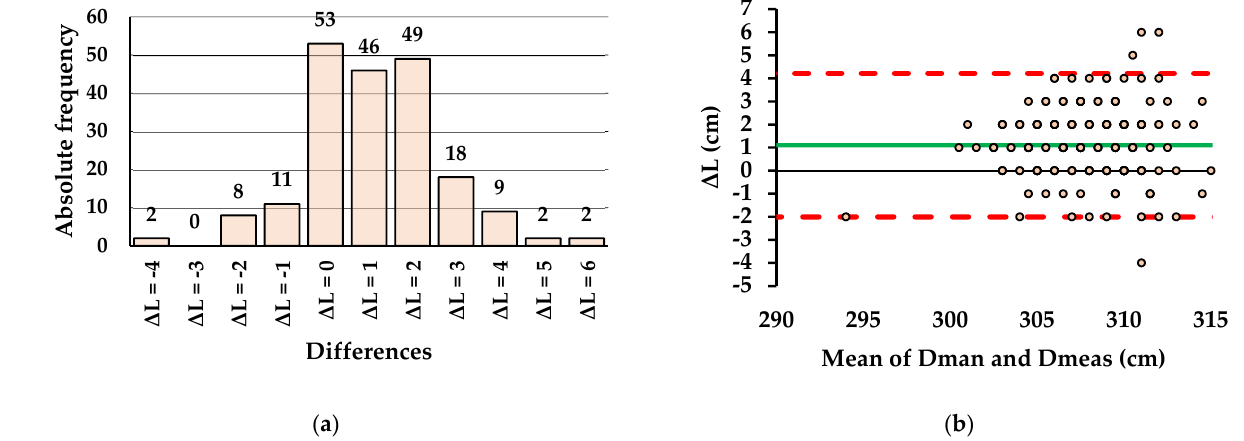
Figure 13. Agreement between the length measurement methods in E2: ( a ) Absolute frequency of differences ( Δ L) between Lman and Lmeas; ( b ) Bland-Altman plot showing the differences plotted against the mean of paired measurements, the bias (green line), and the lower and upper limits of agreement (red dashed lines).